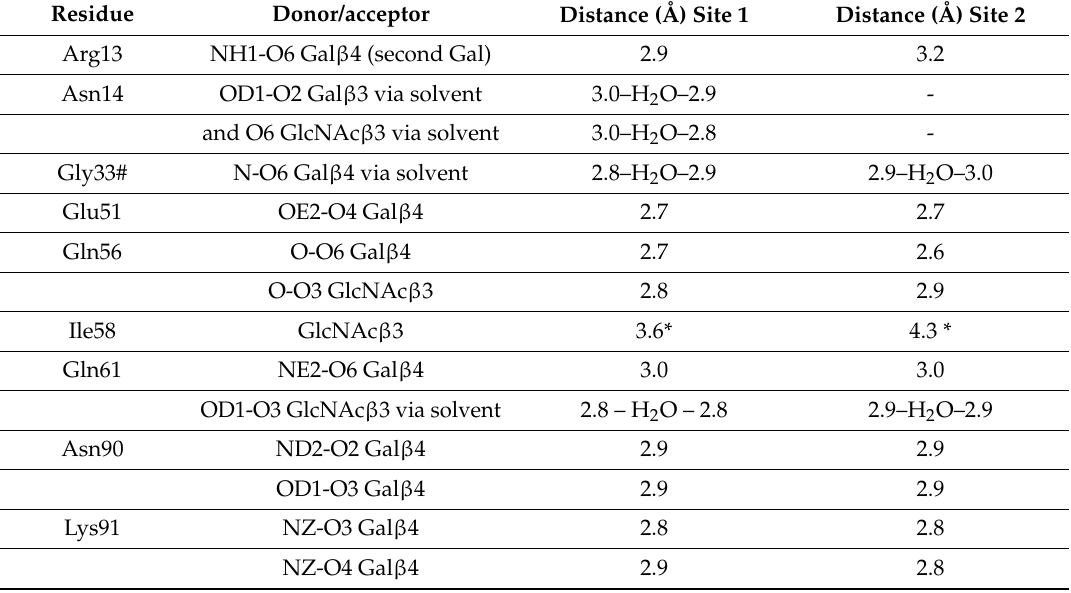
Table 4. Protein–carbohydrate interactions to LNnH (PDB ID: